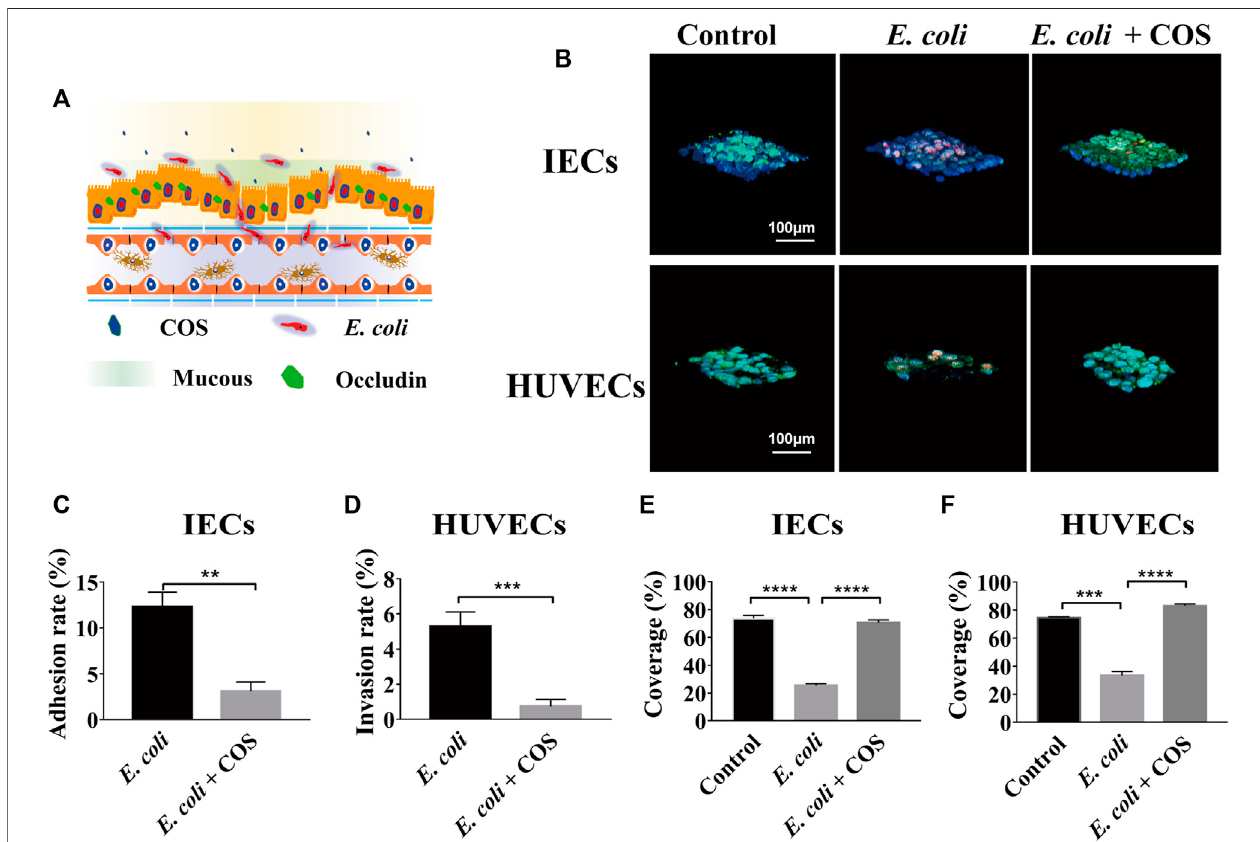
FIGURE 3 | Effects of COS on human enteritis induced by E. coli 11775. (A) Schematic diagram of human enteritis model induced by E. coli 11775. (B) Intestinal mucin and vascular endothelial glycocaly staining using WGA-FITC (Green), intestinal epithelial cells (IECs) an endothelial cells (ECs) staining using blue celltracker, and E. coli 11775 staining using red celltracker. (C) The adhesion rate of E. coli 11775 to IECs. (D) The invasion rate of E. coli 11775 to ECs. (E) The coverage of mucus on IECs. (F) The coverage of glycocaly on ECs. Data were represented as mean ± SD ( n = 3); One-way ANOVA test and Student ’ s test were performed, * p < 0.05, *** p < 0.001, **** p <